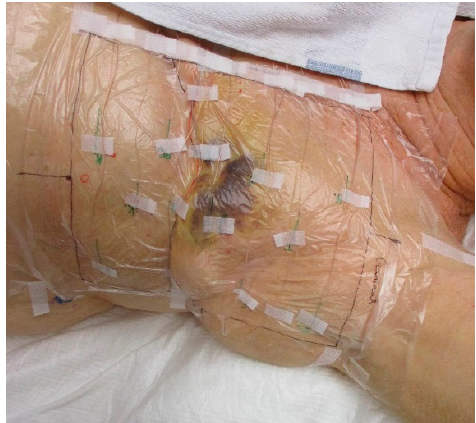
Figure 1. The standard of care thermometry during hyperthermia treatments at the Amsterdam University Medical Centers. Multiple seven-point thermocouples probes are distributed over the skin surface of the target area. To allow accurate positioning and for hygienic reasons a 10 µm high density polyethylene plastic foil is positioned on the chest wall of the patient and the thermocouple probes are placed on the foil.